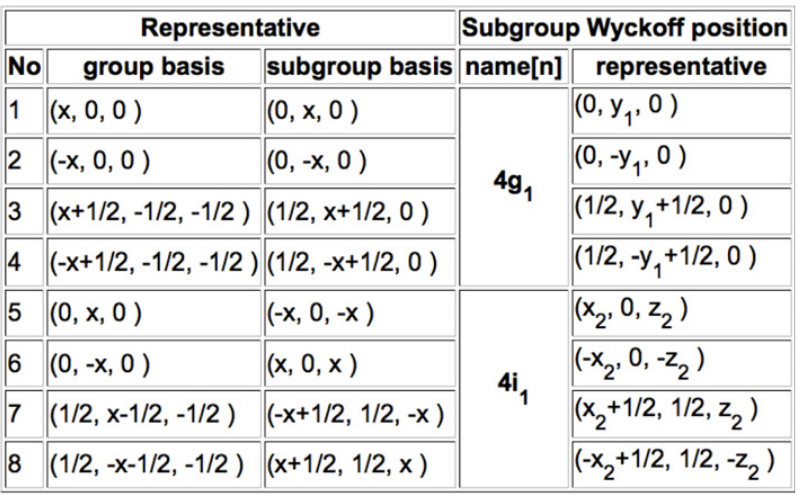
Figure 7. Detailed splitting of orbits 8 i for the symmetry break I 4 /mmm −→ C 2 /m ( − b − c , a , c ;000) as obtained by SYMMODES